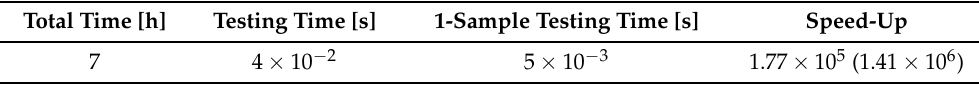
Table 3. Test case 2: POD-DL-ROM GPU computational